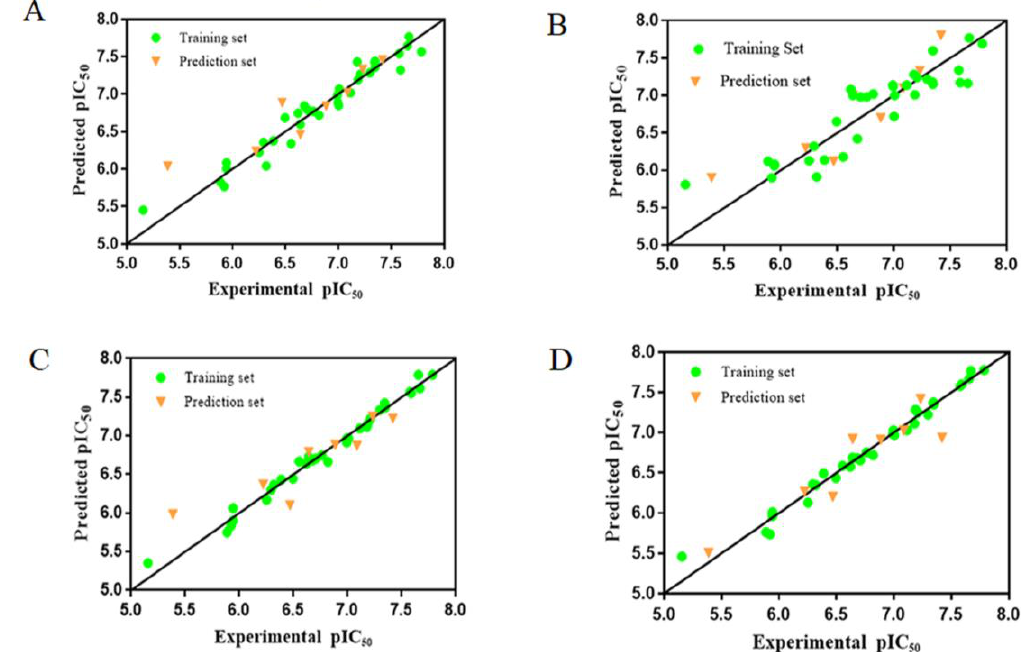
Figure 2. The scatter plots of experimental values vs. predicted values using CoMFA and CoMSIA based on atom-based approach (Alignment A) and docking-based approach (Alignment B). ( A ) is the CoMFA model of Alignment A, ( B ) is the CoMSIA model of Alignment A, ( C ) is the CoMFA model of Alignment B, ( D ) is the CoMSIA model of Alignment B.